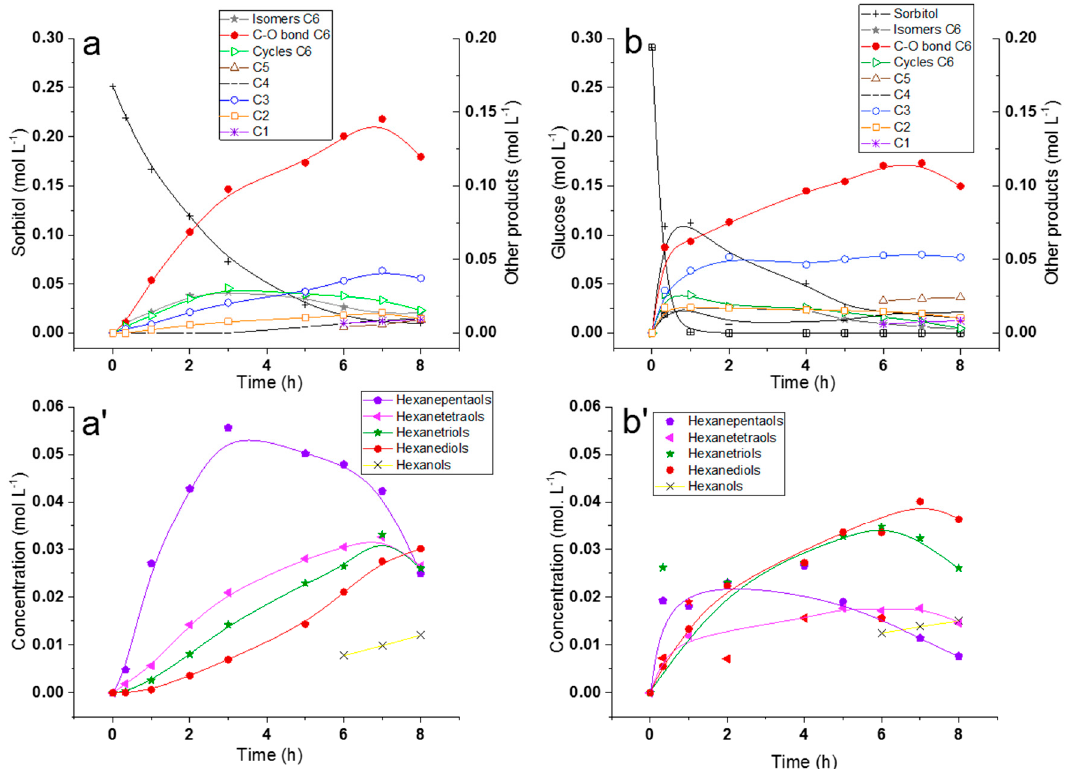
Figure 1. The evolution of the concentration of ( a , b ) the different families of products and ( a’ , b’ ) the sub-families of linear deoxygenated C6 compounds during hydrogenolysis of ( a , a’ ) sorbitol (0.25 M), and ( b , b’ ) glucose (0.29 M), over ReO x -Rh/ZrO 2 catalysts (Re/Rhmolar ratio = 1.5 for sorbitol, 1.6 for glucose) at 200 °C under 80 bar H 2 , n sorbitol /n Rh = 188, n glucose /n Rh = 218.